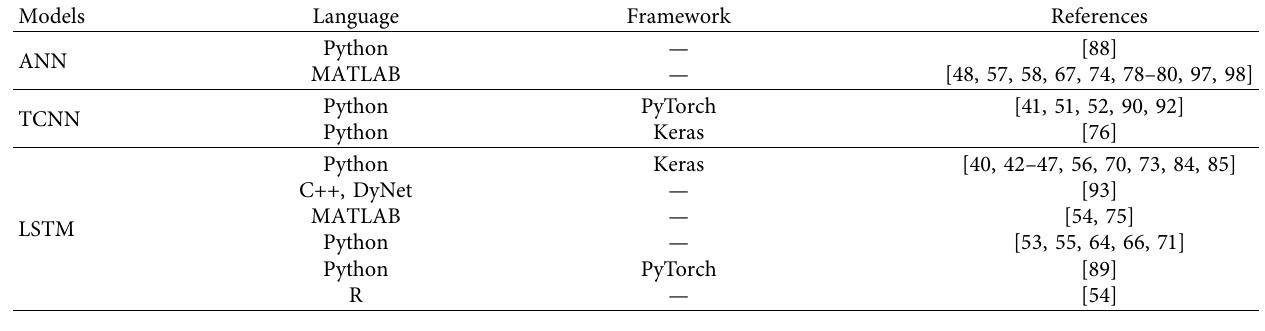
Table 8: Implementation framework for the reviewed papers.